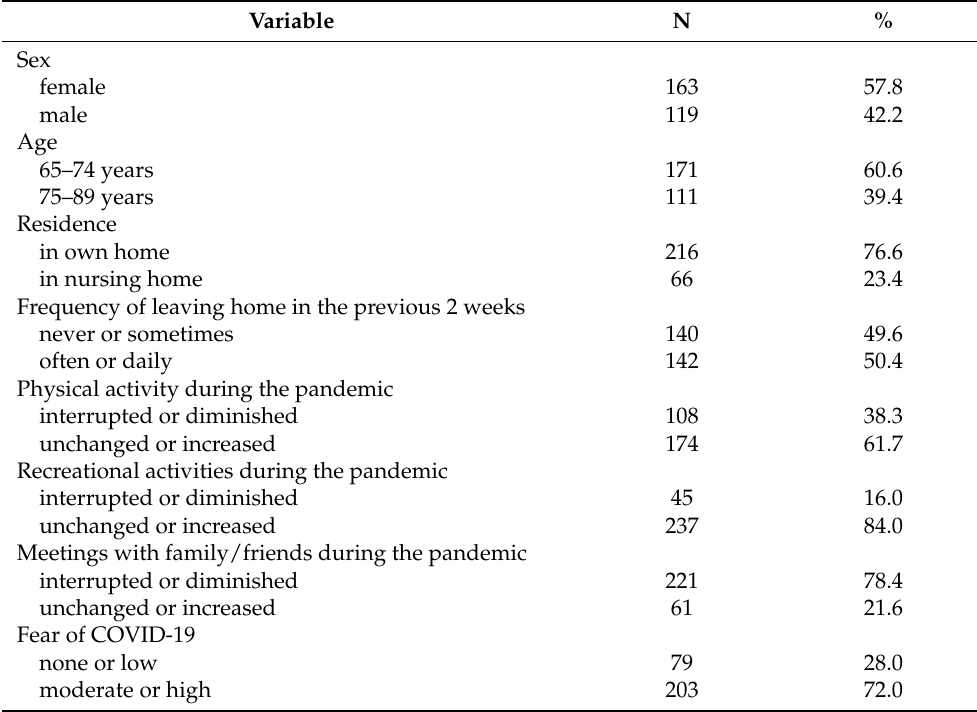
Table 1. Characteristics of study participants (N =